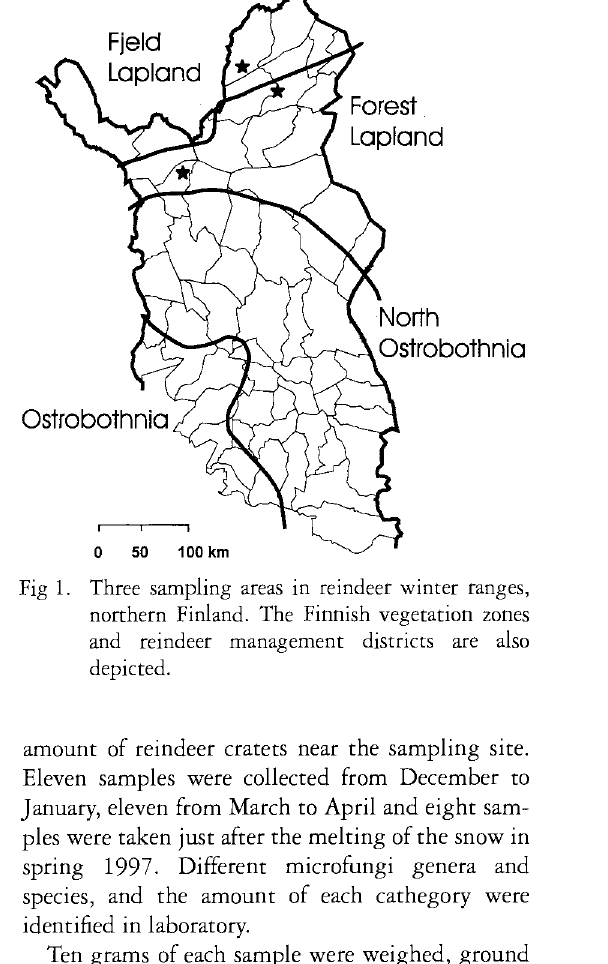
Fig 1. Three sampling areas in reindeer winter ranges, northern Finland. The Finnish vegetation zones and reindeer management districts are also